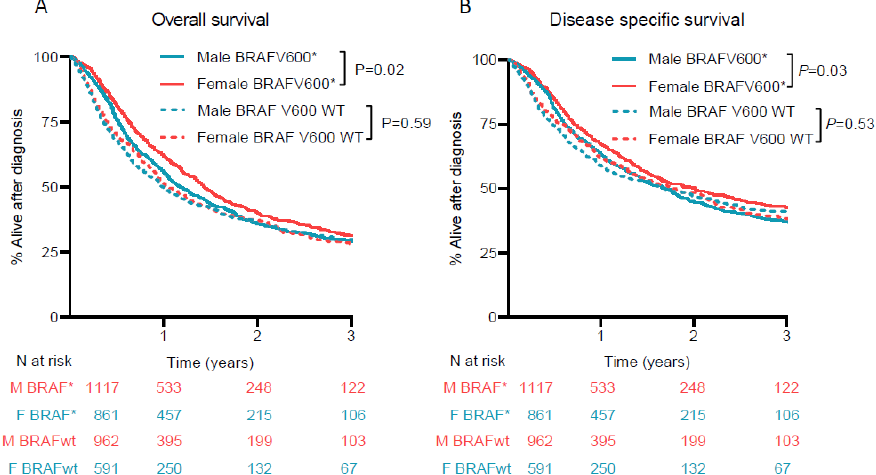
Figure 3. Overall and disease specific survival in men and women stratified by BRAF mutational status ( A ) Overall survival in years since diagnosis of advanced melanoma in patients with a BRAF V600 mutation (BRAFV600 */BRAF *) and patients proven to be BRAF V600 wild type (BRAF V600 WT/BRAFwt). ( B ) Disease specific survival in years is shown since diagnosis of advanced melanoma in patients with a BRAF V600 * and patients proven to be BRAF V600 WT. M = men, W = women, “*” = mutation.